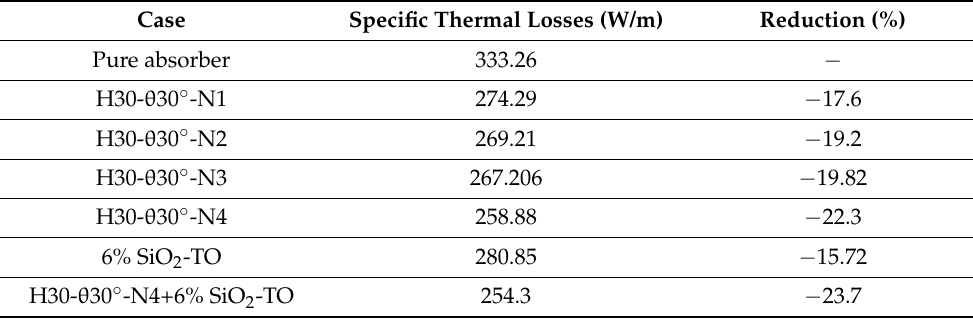
Table 8. Thermal loss reductions for single and multiple conical insert cases with and without nanofluid at Re = 10,000.